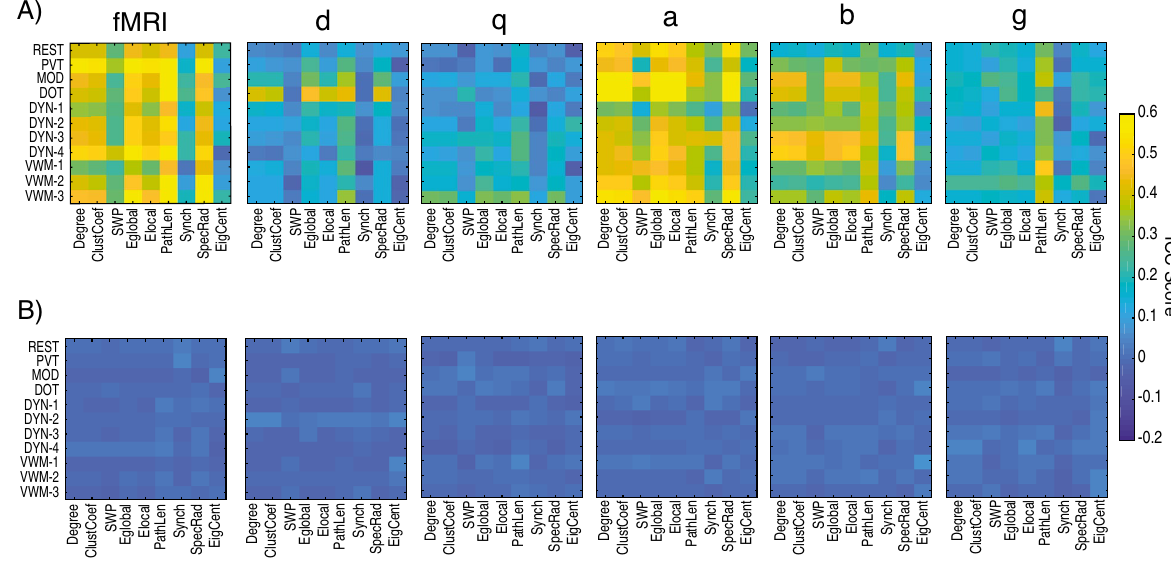
Figure 6. ICC values for network measures across task and resting-state. ( A ) ICC w and ( B ) ICC b values across tasks for fMRI and EEG frequency